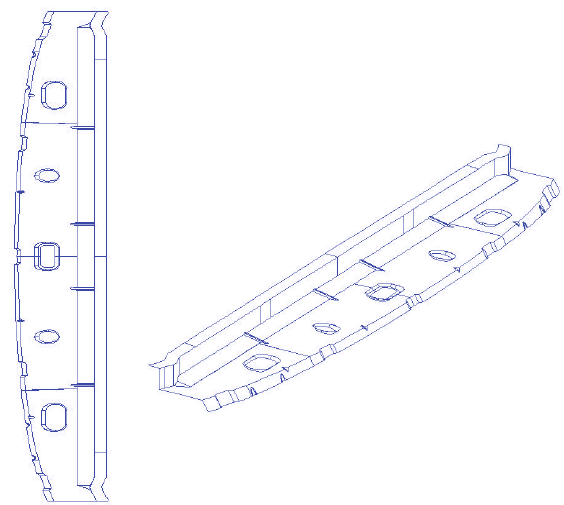
Figure 6: Two different views of a 3D CAD/CAM workpiece comprised of 1610 curves ( courtesy of Candemat